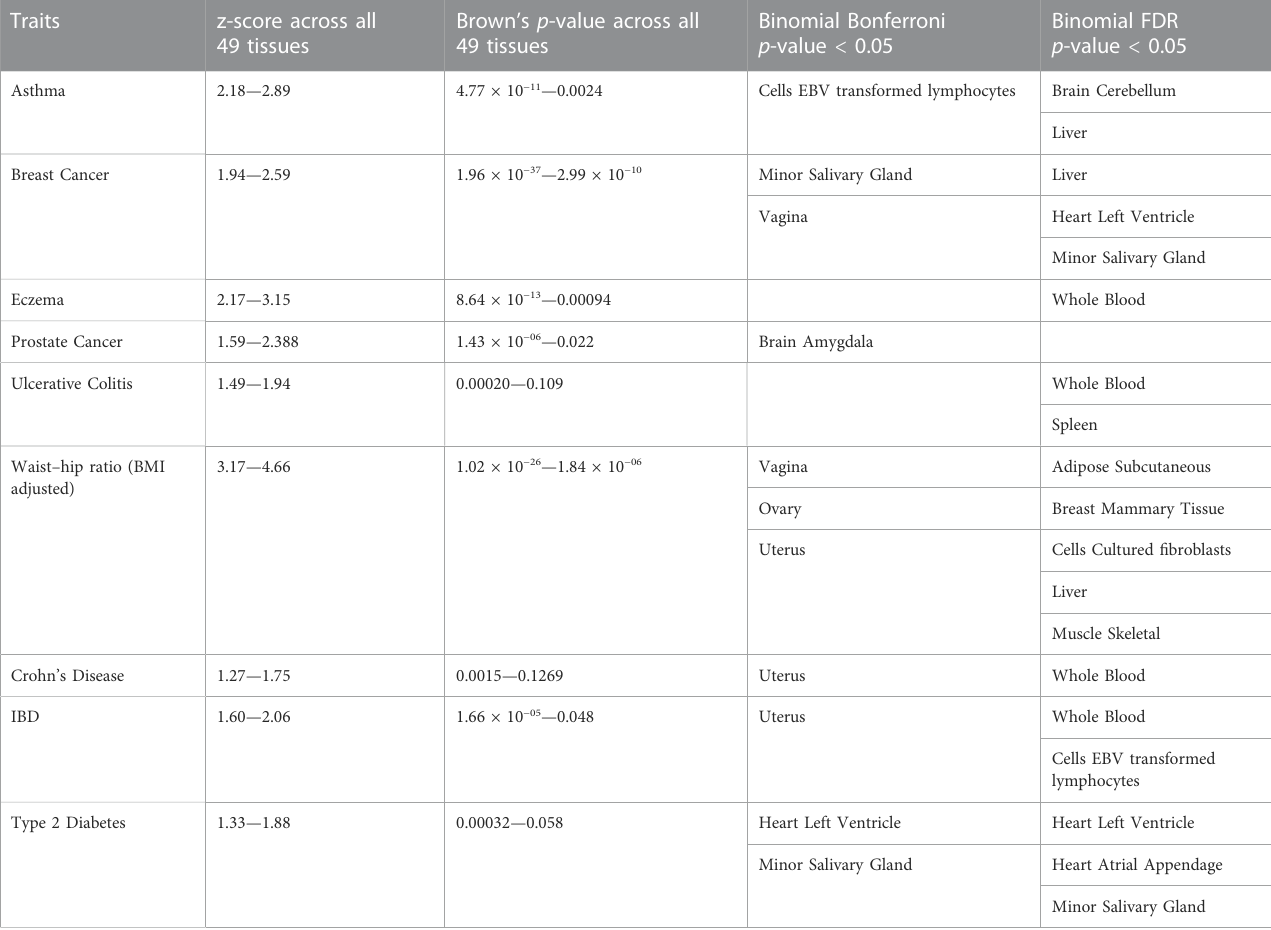
TABLE 3 Unadjusted mean squared z-score, Brown ’ s p -value and tissues crossing nominal Bonferroni and FDR p < 0.05 for the training dataset.